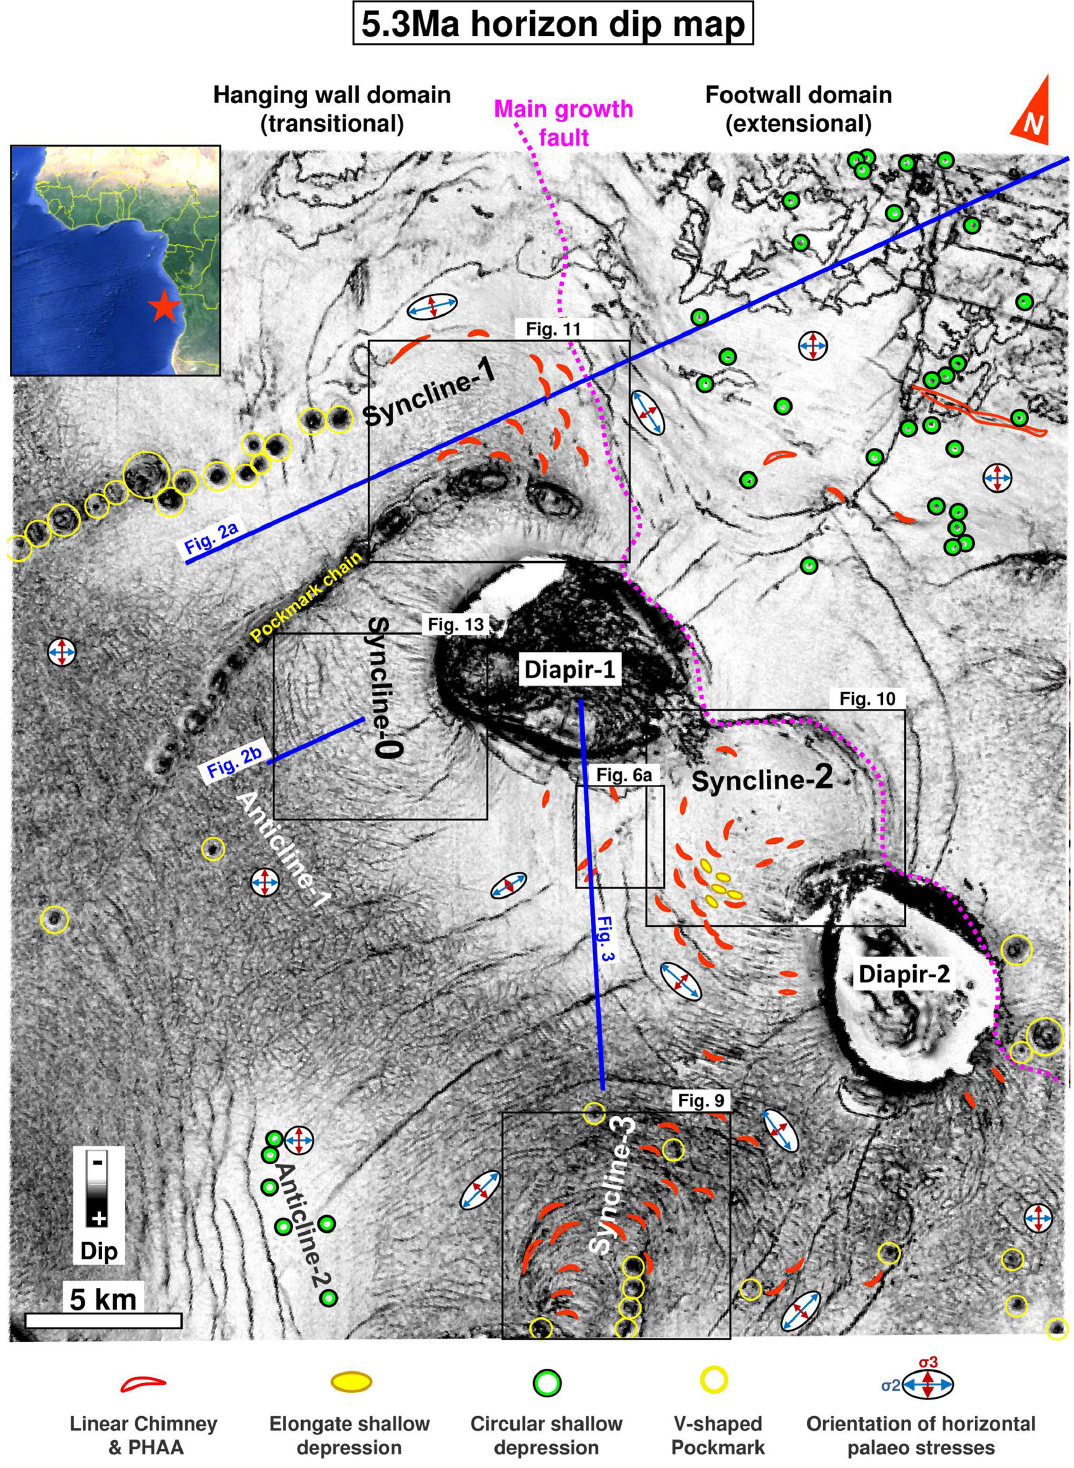
Figure 1. Dip map of referential horizon 5.3Ma showing distributions of fluid expulsion structures across the study area. Subtypes of fluid expulsion features are shown diagrammatically (see legend below main figure). Palaeo-stress ellipses show relative directions and magnitudes of the horizontal principal stresses and are constructed from the planform geometry of the polygonal fault networks (see Sect. 3.2.3 for more information). The blue axis and red axis on stress ellipses indicate the palaeo-orientation of the intermediate and minimum stresses, respectively. The location of the seismic survey is indicated by a red star on the insert